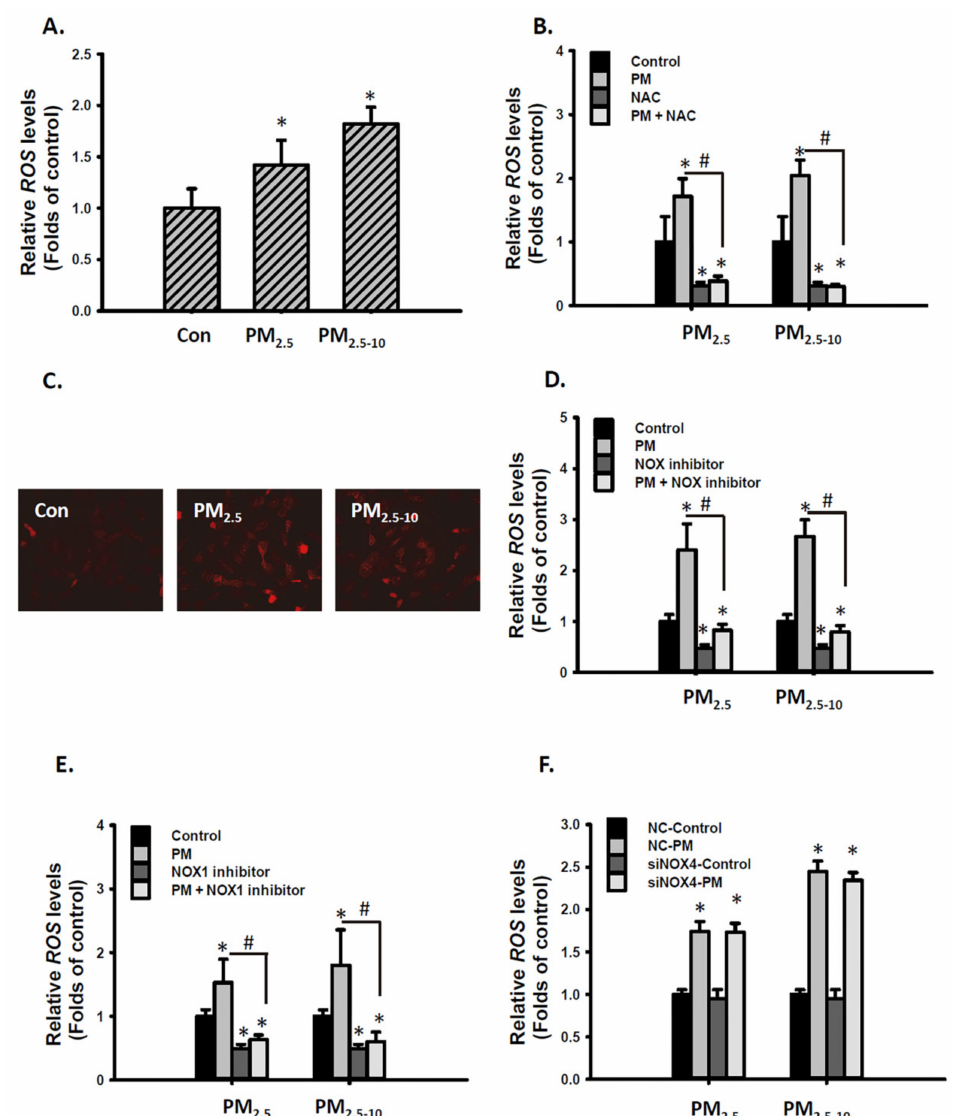
Figure 3. PM 2.5 and PM 2.5-10 increased ROS levels through the NOX1 dependent pathway in MVSMCs. ( A ) MVSMCs were treated with d 2 H 2 O or 12.5 µ g/mL PM 2.5 or PM 2.5-10 for 2.5 h. ( B ) MVSMCs were treated with d 2 H 2 O or 12.5 µ g/mL PM 2.5 or PM 2.5-10 with and without 10 µ M NAC for 2.5 h. ( C ) MVSMCs were treated with d 2 H 2 O or 12.5 µ g/mL PM 2.5 or PM 2.5-10 for 24 h, and mitochondrial ROS were detected with MitoSOX. ( D ) MVSMCs were treated with d 2 H 2 O or 12.5 µ g/mL PM µ M of NOX inhibitor for 2.5 h. ( E ) MVSMCs were treated with d 2.5 or PM 2.5-10 with and without 10 2 H 2 O or 12.5 µ g/mL PM µ M of NOX1 inhibitor for 2.5 h. ( F ) NC-MVSMCs and siNOX4-MVSMCs 2.5 or PM 2.5-10 with and without 10 were treated with d 2 H 2 O or 12.5 µ g/mL PM 2.5 or PM 2.5-10 for 2.5 h. Intracellular ROS levels were quantified using the cellular H 2 DCFDA assay. The results are presented as the mean ± SD for three or four independent experiments. * p < 0.05, compared with vehicle-treated cells. # p < 0.05, compared with inhibitor-treated cells. Con: d 2 H 2 O treatment as control; NC: negative control for